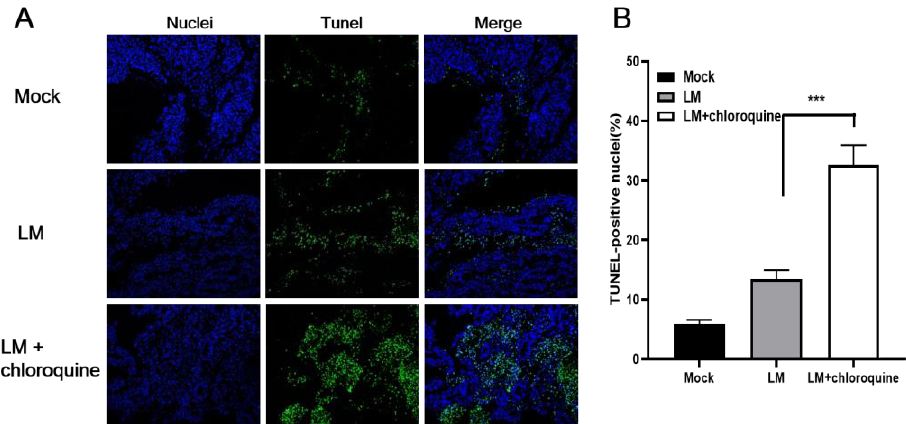
Figure 4. Synergistic inhibition of tumor growth in tumor-bearing mice with combined treatment with LM + CQ. ( A ) Survival rates of mice bearing B16F10 melanomas were analyzed by Kaplan – Meier survival curves. Survival curves were compared by the log-rank test. ( B ) Tumor-bearing mice ( n = 6 for each group) were treated with LM, PBS, or LM + CQ. Tumor volumes in the different groups were compared. All data are presented as the means ± SD. *** p < 0.001.